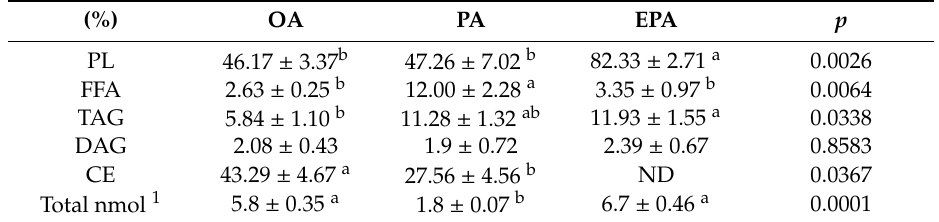
Table 2. Relative distribution of radioactivity from [1- 14 C PA] recovered in di ff erent cellular lipid classes in Atlantic salmon di ff erentiated adipocytes incubated with oleic (OA), palmitic (PA), or eicosapentaenoic acid (EPA) for 72 h.